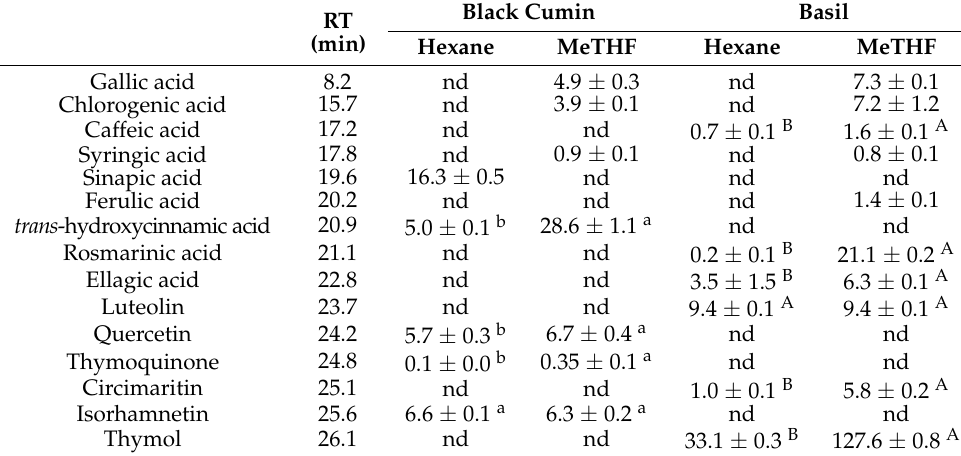
Table 5. Phenolic compounds identification ( µ g/g oil) in black cumin and basil seed oils after extraction by hexane and